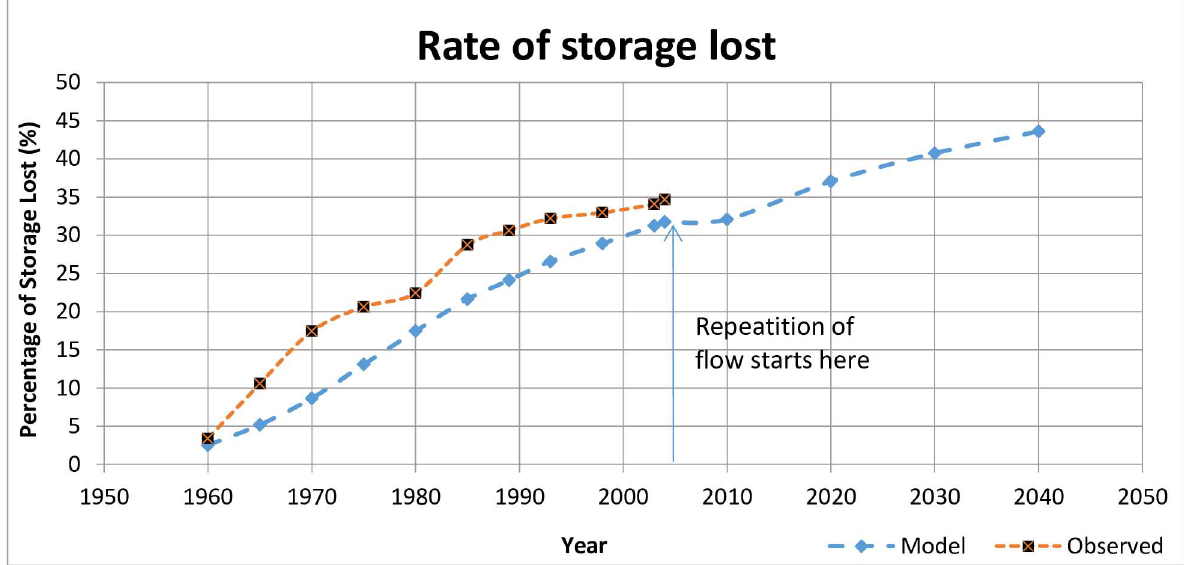
Fig 7. Comparison of rate of storage lost between modeled and observed reservoirs. The line showingmodeledvalues also shows predictiveloss of storage after 2004.